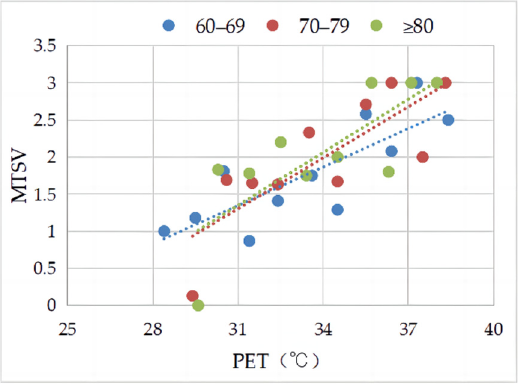
Figure 8. Correlation between MTSV and PET in elderly of different age groups. Table 5. Neutral PET and neutral PET range of elderly in different age